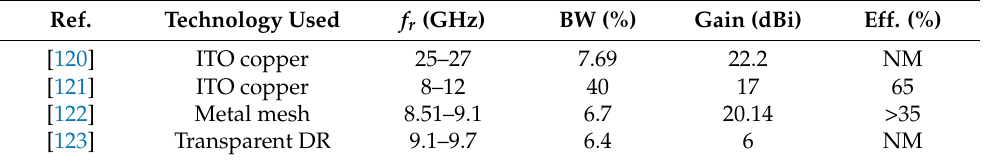
Figure 30. Transparent resonator antenna on silicon solar cell: ( a ) top view; ( b ) fabricated prototype [123].